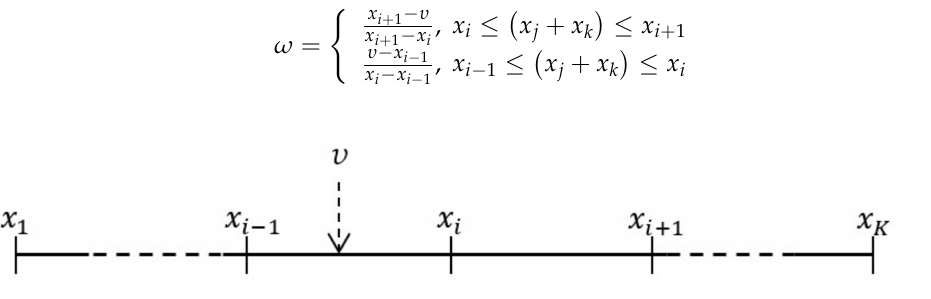
Figure 1. Computational